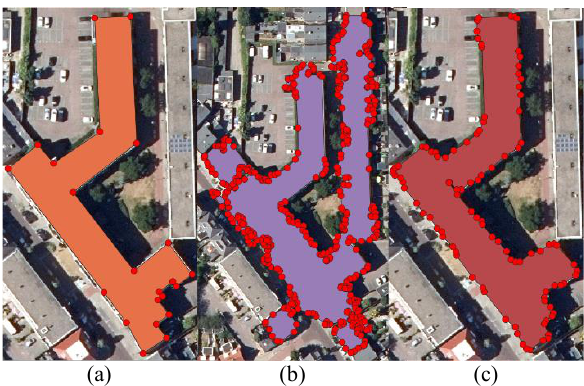
tolerance. In the lower right part of the polygon, as the vertices are simplified, the edge deviates from the ground truth too.